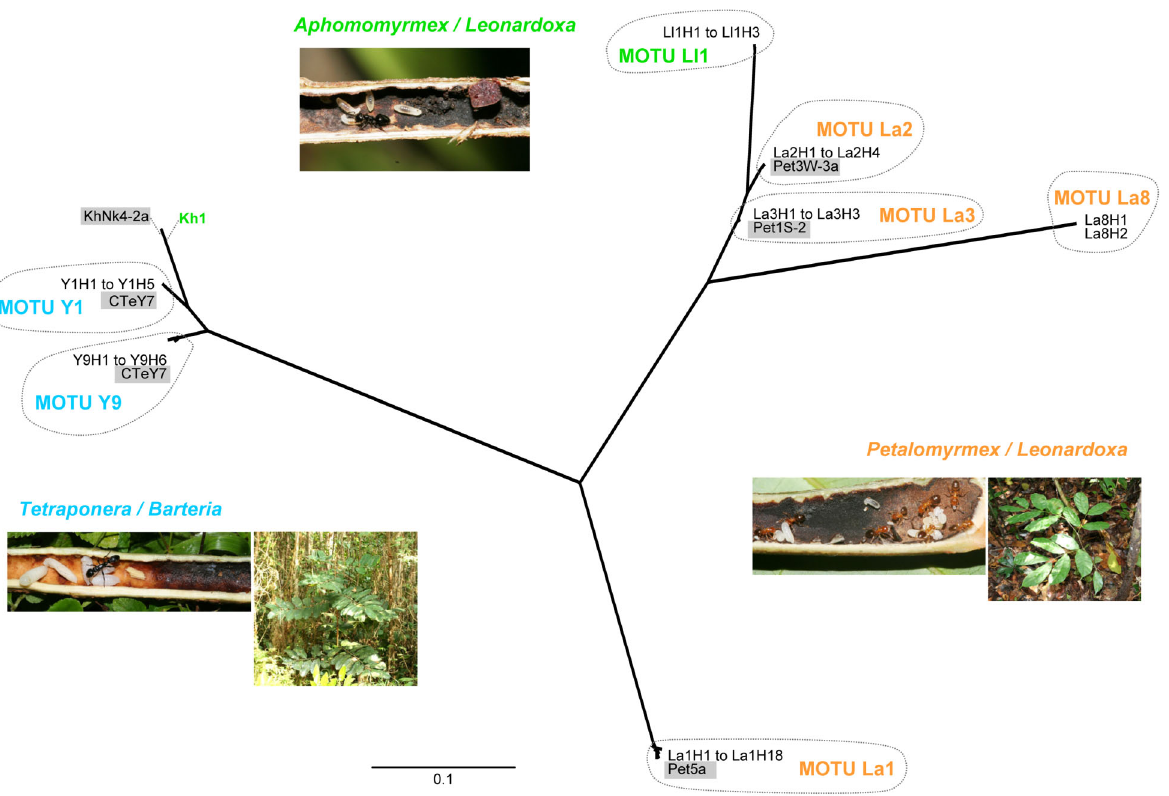
Figure 1. Maximum likelihood tree of ITS fungal haplotypes from three ant-plant-fungus symbioses. A total of 42 haplotypes (based on sequences of 647 aligned nucleotides) of Chaetothyriales were detected in fungal patches of the following ant-plant symbioses: Petalomyrmex phylax/Leonardoxa africana subsp. africana (MOTUs in orange), Aphomomyrmex afer/Leonardoxa subsp. letouzeyi (MOTU in green) and Tetraponera aethiops/Barteria fistulosa (MOTUs in blue). Note that haplotype Kh1 is labelled in green because it was detected in the system Aphomomyrmex / Leonardoxa , although it is phylogenetically most closely related to MOTU Y1. The position of each MOTU on the tree is indicated by the intersection of the branches and the dotted lines. Branch tip labels highlighted in grey correspond to fungal strains obtained in previous studies following a culturing approach. For each symbiosis, the image on the left displays a domatium cut longitudinally to expose ants and a fungal patch (dark area on the inner surface). MOTU: Molecular Operational Taxonomic Unit.